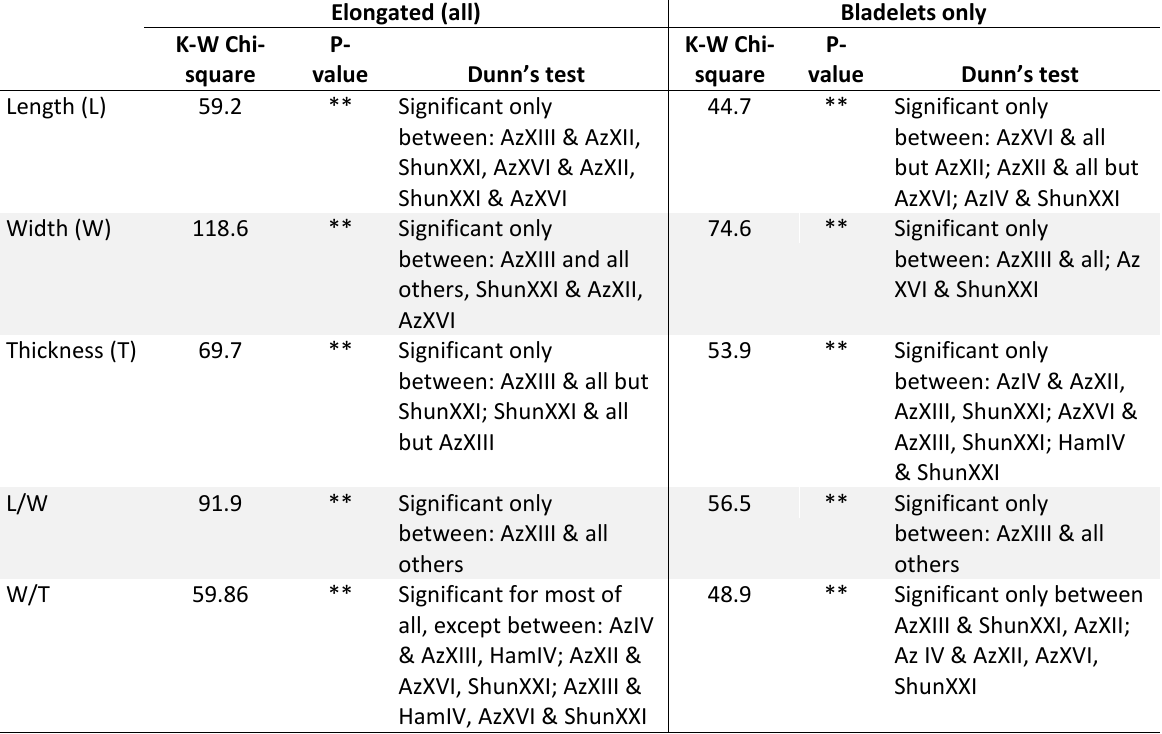
Table 7. Results of Kruskal-Wallis tests and post-hoc Dunn’s test (Carlson 2017: 182; Dunn 1964) for the comparisons of dimensions of elongated blanks between sites. Abbreviations: ** p-value < .01; Az - Azariq; Shun - Shunera; Ham -